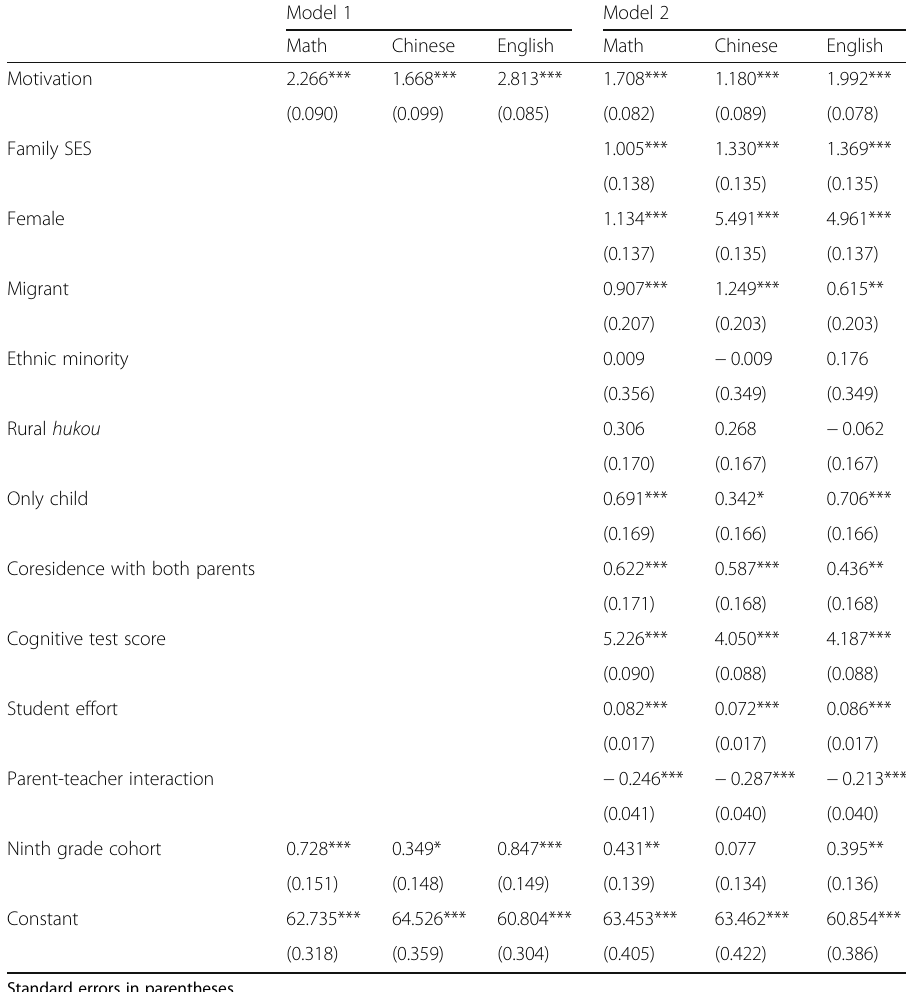
Table 3 School fixed effect models predicting student performance ( N = 17,284) Model 1 Model